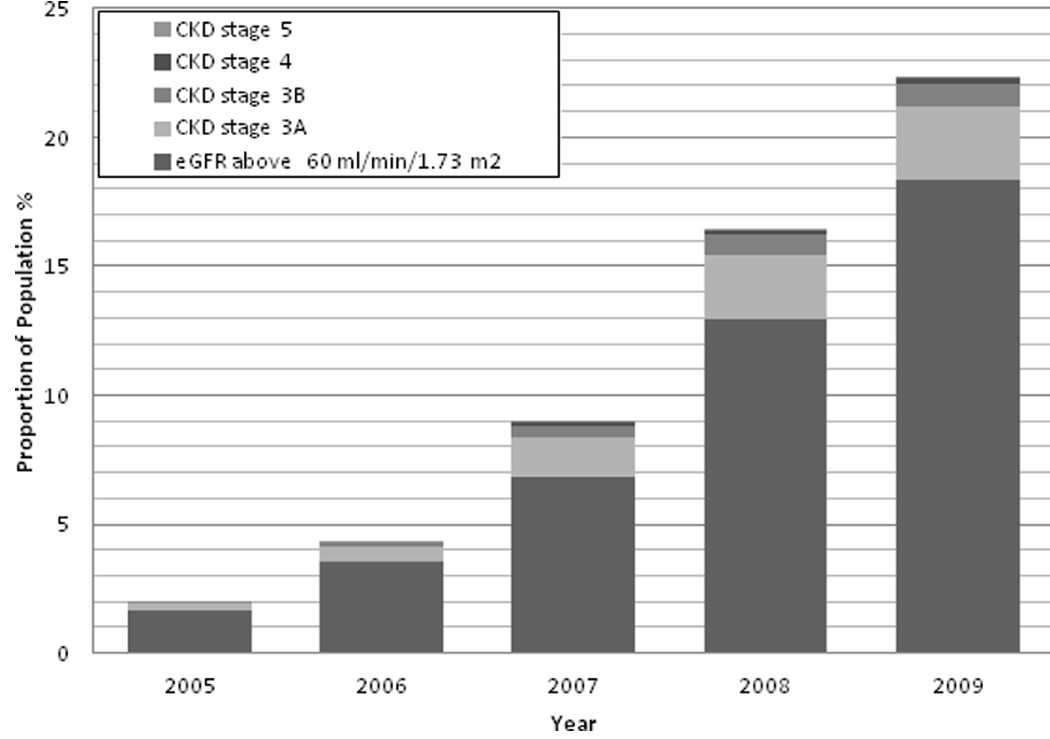
Figure 2. Age standardised prevalence (%) of stages 3–5 CKD from 2005–2009. CKD stage was defined by the last two consecutive laboratory eGFRS at least seven days apart in the year in question. Note figures are approximated to the nearest decimal place and therefore may be slightly different from the total figure.